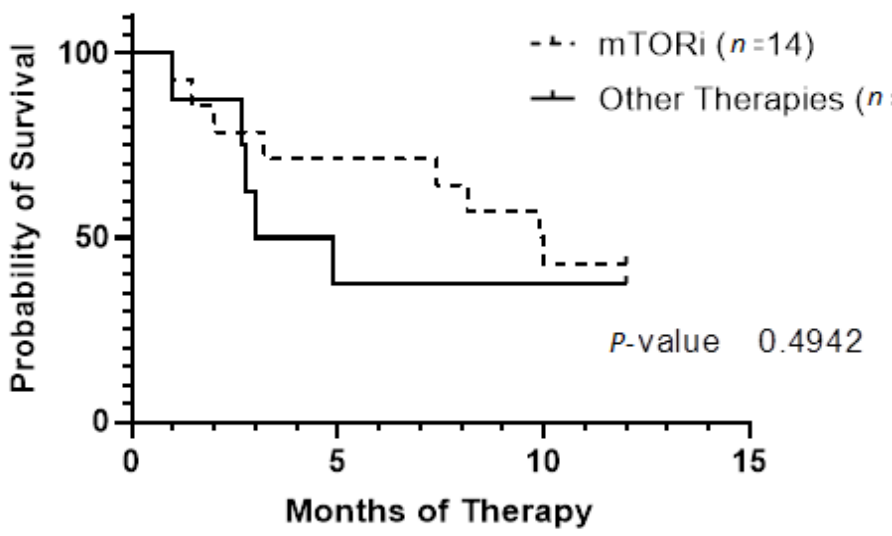
Figure 3. Progression-free survival based on first-line systemic therapy censored at 12 months. Patients included in this analysis underwent systemic therapy for their PEComa (n = 22). Fourteen patients had first-line therapy with mTOR inhibition. Only two patients did not meet criteria for malignant PEComa; they had initial resection with local recurrence requiring systemic therapy. Abbreviations: PFS1, progression-free survival of first-line therapy; mTORi, mTOR inhibition. Table 1. Baseline characteristics. * Some cases had multiple mutations.